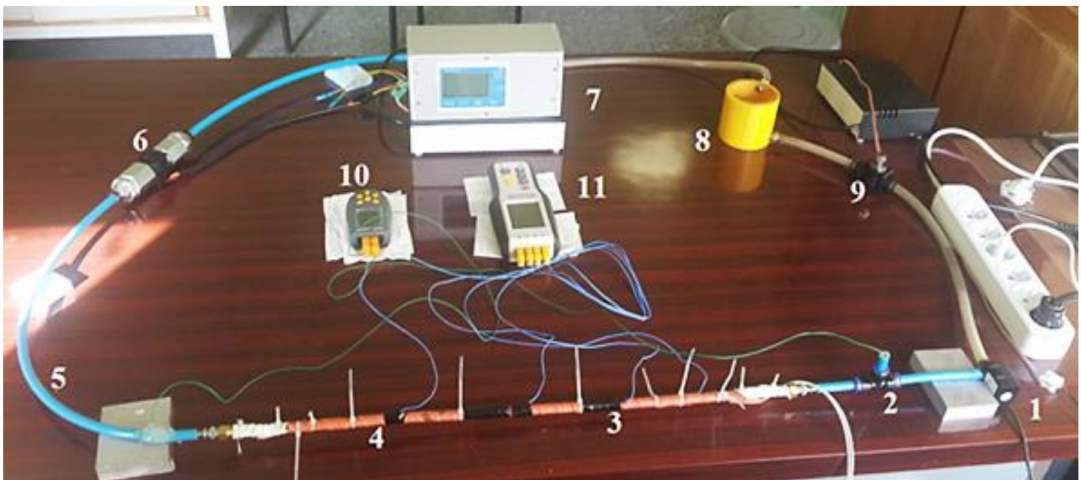
Figure 2. The experimental setup ( 1 ) Pump; ( 2 ) T Connection reducer elbow pipe; ( 3 ) Heat Band; ( 4 ) Copper pipe; ( 5 ) Plastic pipe; ( 6 ) Flow Measurement Electronic device sensor; ( 7 ) Flow Measurement Electronic device; ( 8 ) Fluid reservoir; ( 9 ) Flow Adjustment Valve; ( 10 ) Fluid Thermometer; ( 11 )